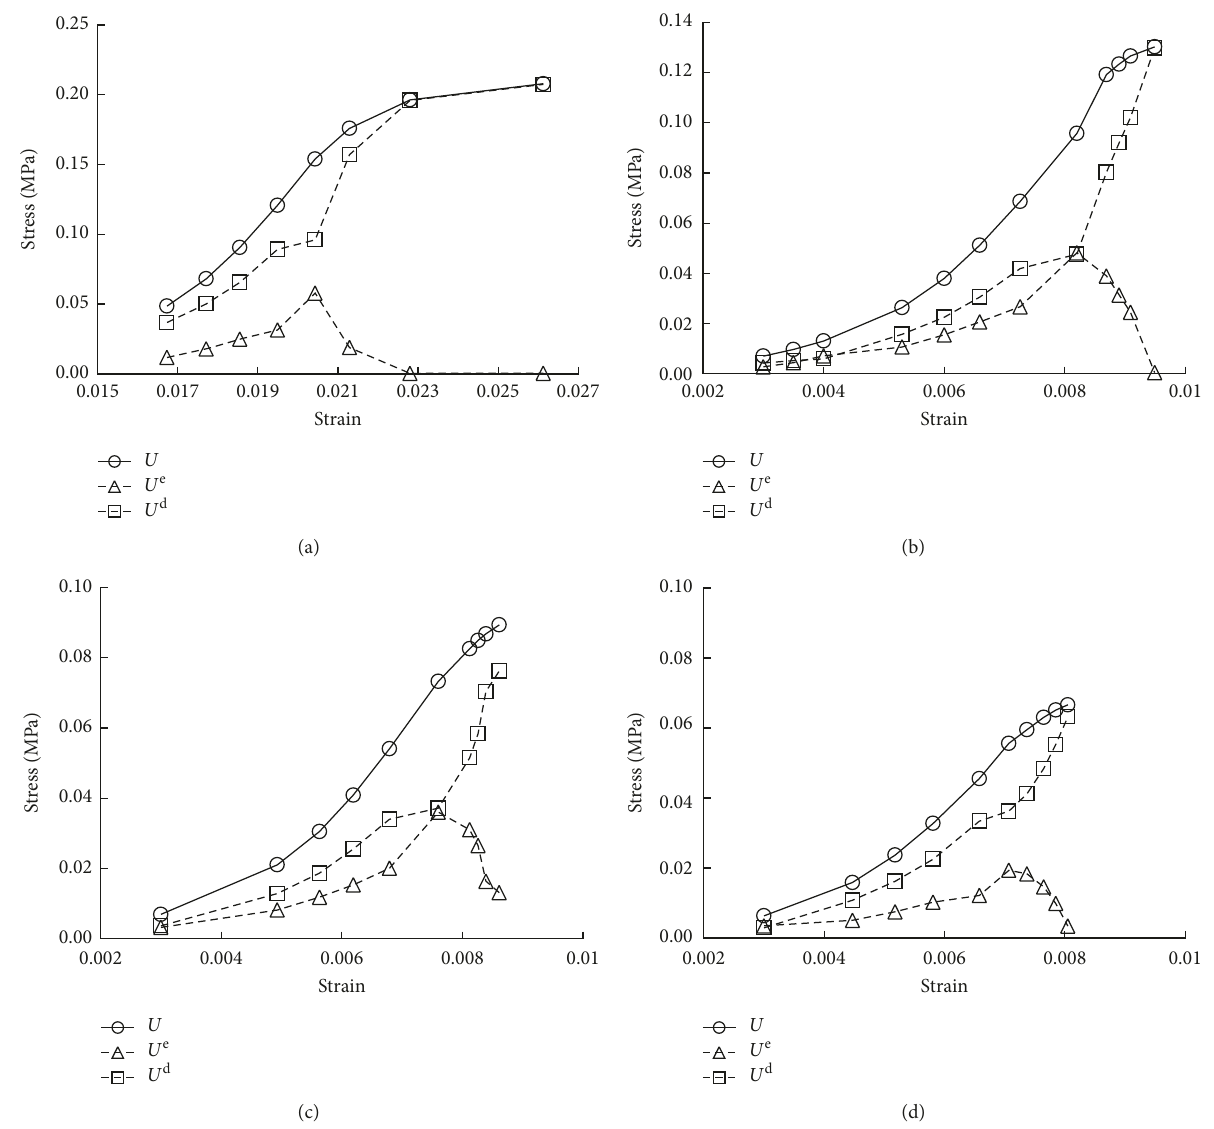
Figure 3: Energy evolution curves of samples with different water contents: (a) 0%, (b) 25%, (c) 50%, and (d)